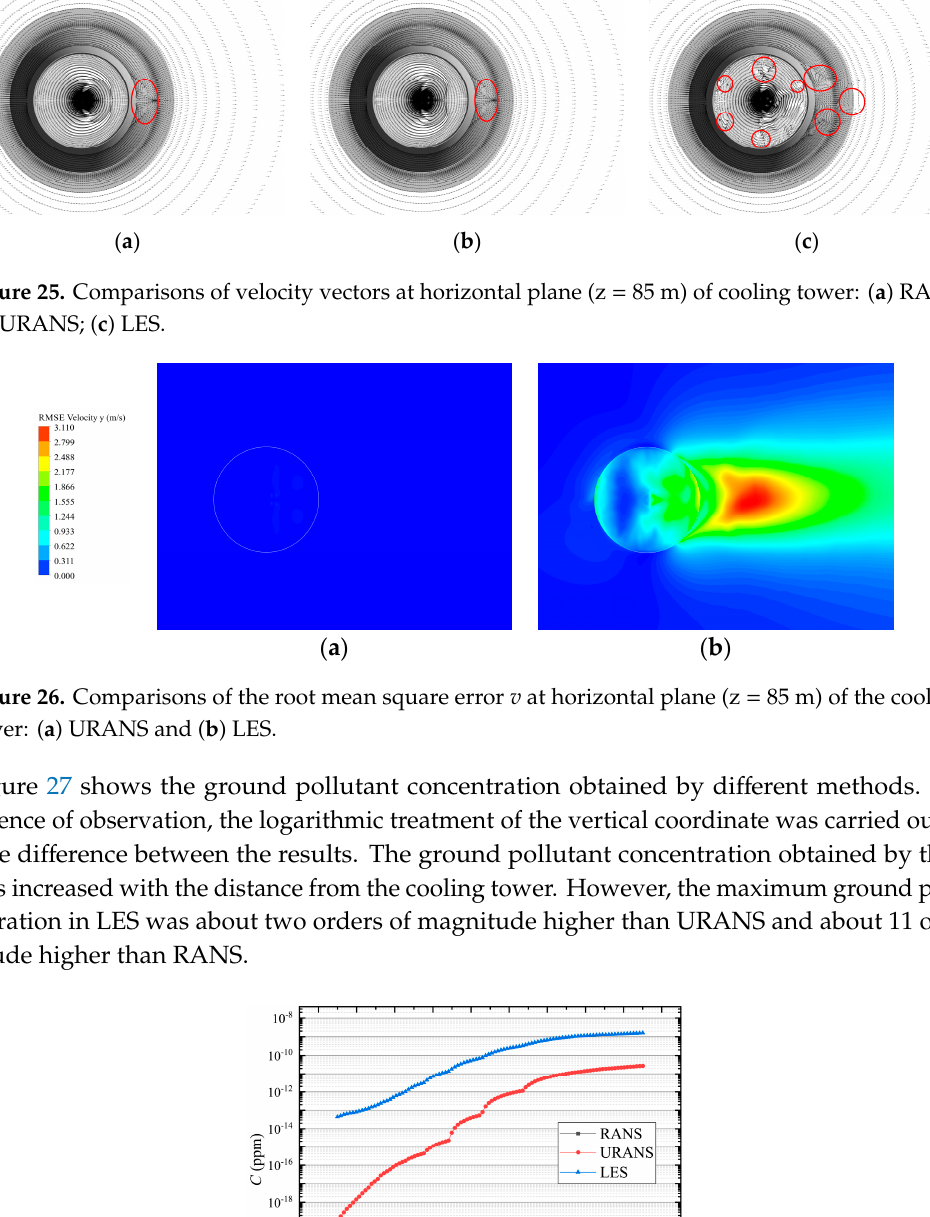
Figure 27. Comparisons of concentration at ground level.